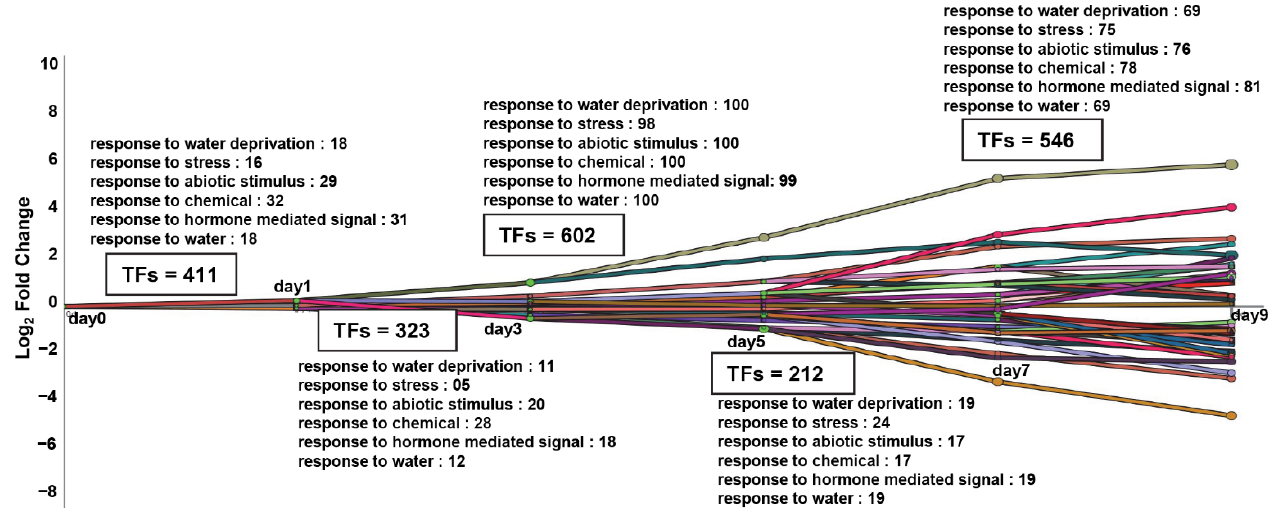
Figure 3. The plot illustrates the interactive Dynamic Regulatory Events Miner (iDREM) of drought response in Arabidopsis from day 0 to 9 at significance p < 0.01. The ontology identified the transcrip- tion factors (TFs) and genes involved in different functions on different days of drought stress. Each colored line corresponds to a unique transcriptional regulatory path and numbers of TFs representing each functional category are listed in text boxes.